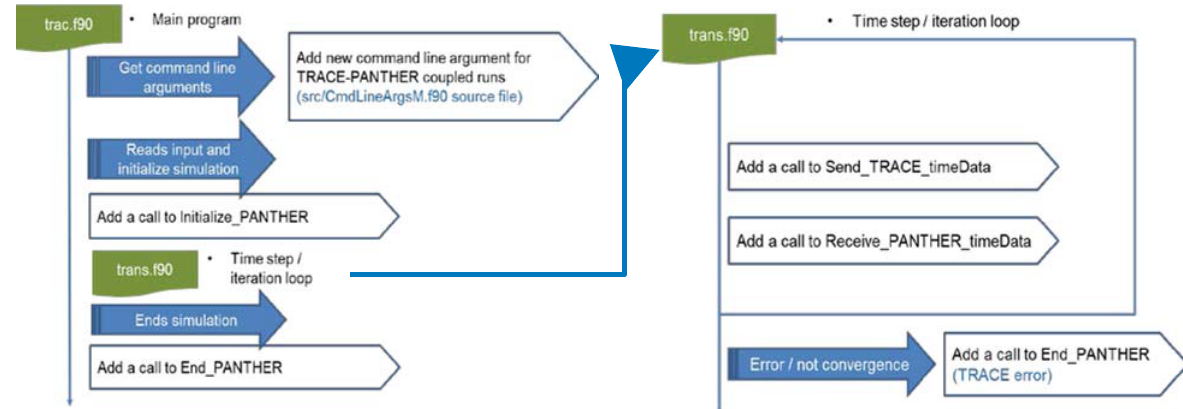
Figure 3. Schematic coupling between TRACE and